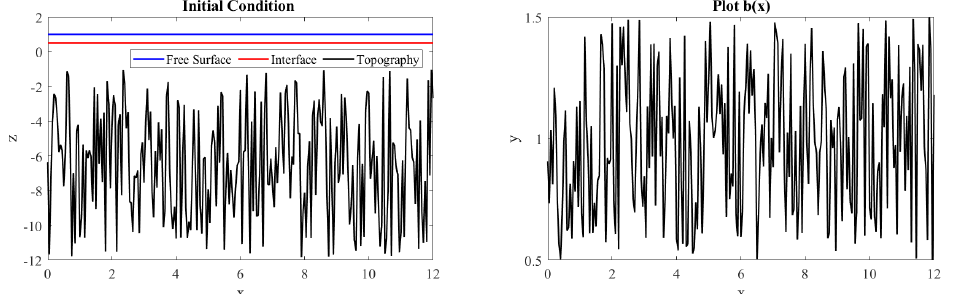
Figure 3. ( Left ) The randomly generated channel bed and the initial free surface and interface. ( Right ) The randomly generated channel width.